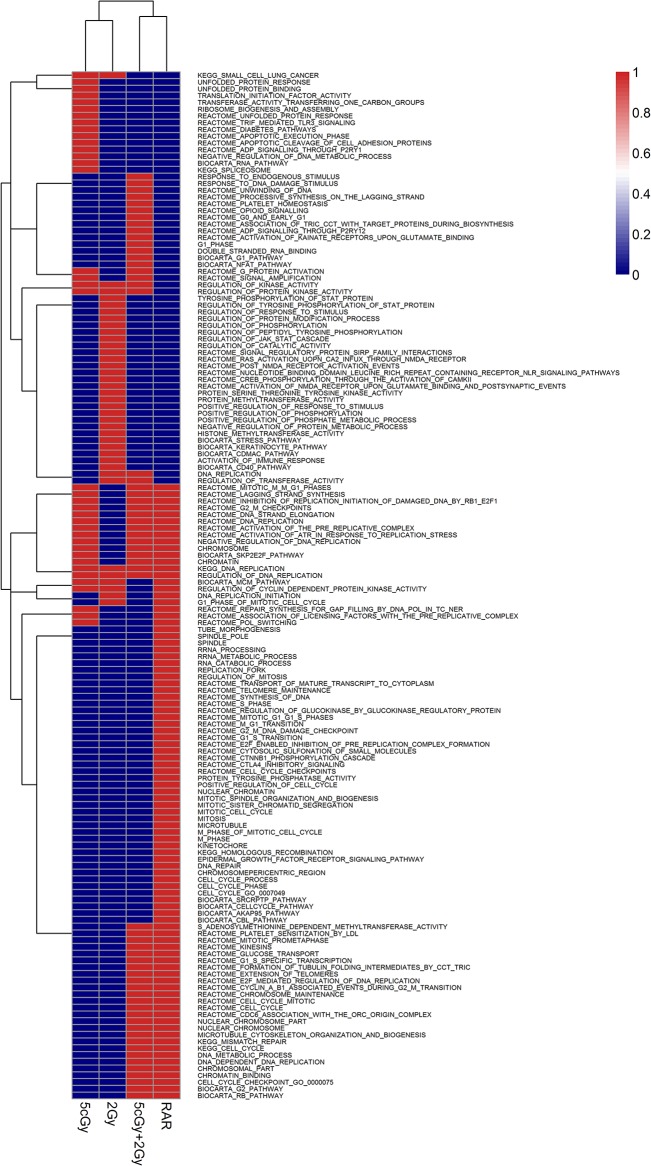
Clustering of GSEA results enriched with negative correlation with increased time profile.Sorting negative correlation The GSEA results were sorted by FDR < 25% or nom p value < 1% thresholds, where appropriate. The heatmap illustrated the gene sets for each irradiation group. The red color codes for the presence of the shown gene sets in a particular group, while the blue color codes for absence of the shown gene sets in a particular group.